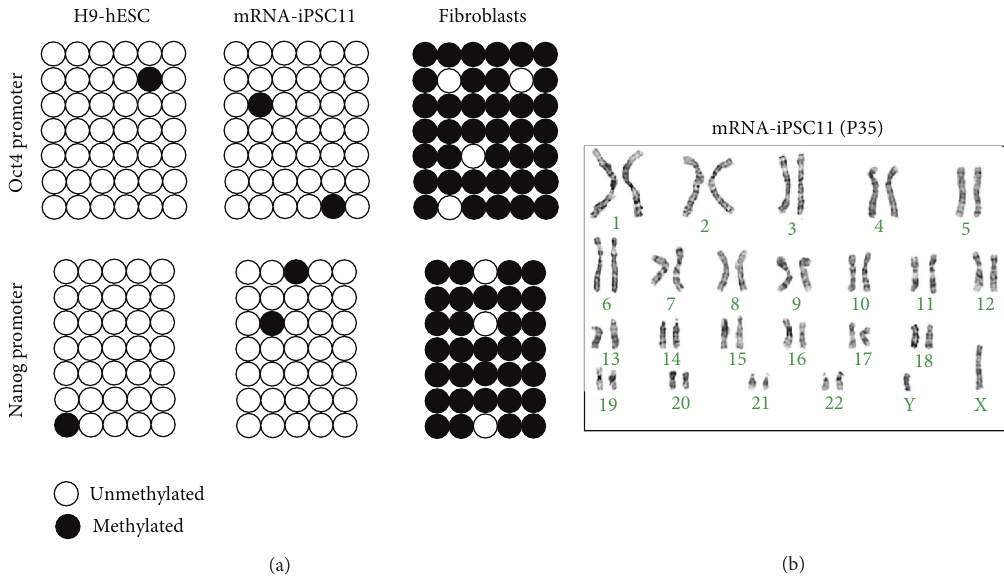
Figure 5: Analyses of the methylation in the Oct4 and Nanog promoters and of chromosomal abnormality in the mRNA-iPSCs. (a) The bisulfite sequencing data indicated that the promoters of the Oct4 and Nanog genes in the mRNA-iPSCs were largely demethylated, similar to the methylation status of these promoters in hESCs. In contrast, their original cells, fibroblasts, were hypermethylated at these promoters. (b) G-banding analysis showed that no apparent chromosomal abnormality was generated during reprogramming and extended culture (for 35 passages) of the mRNA-iPSCs in our ECM-based xeno-free/feeder-free hPSC culture